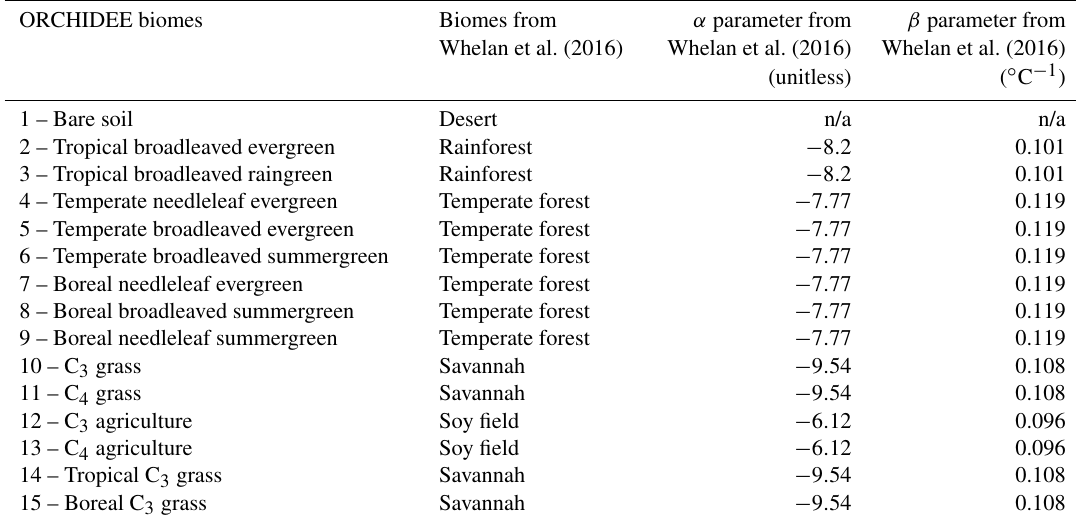
Table A2. α and β parameters for COS production term adapted to ORCHIDEE